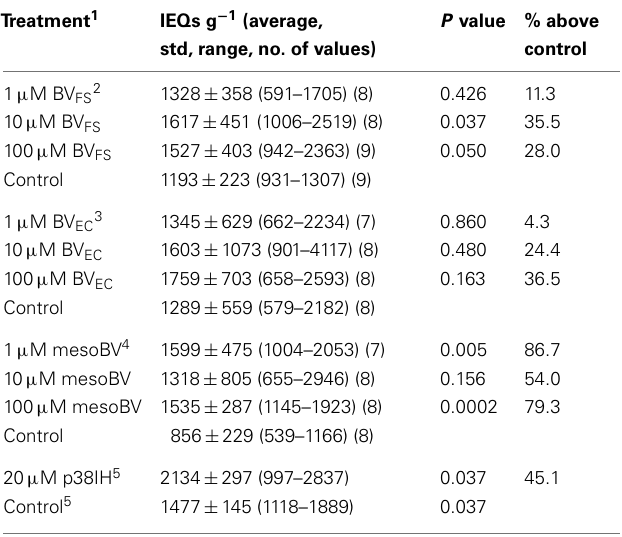
Table 1 | Islet yields from pancreata infused with biliverdin IX α -HCl and mesobiliverdin IX α